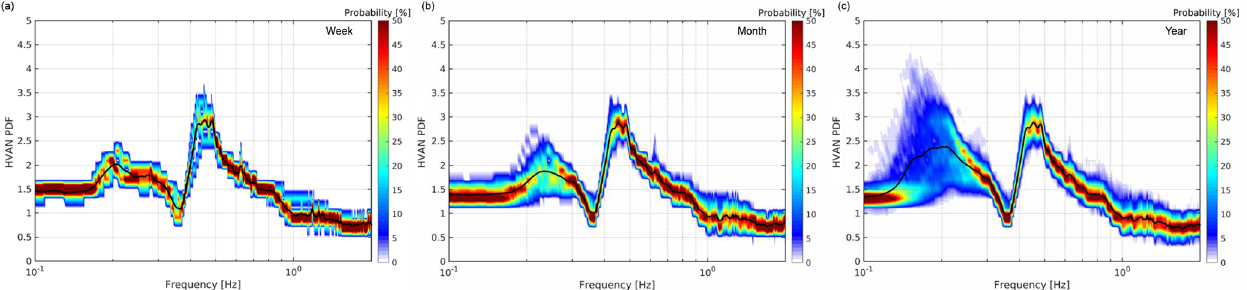
Figure 10. Probability density functions (PDFs) from ambient noise horizontal-to-vertical spectral ratios (HVAN) for station G39, 50m level. The black line represents the mean. (a) HVAN PDF for 1 week (21–28 March 2017). (b) HVAN PDF for 1 month (1 May–1 June 2017). (c) HVAN PDF for 1 year (1 February 2017–1 February